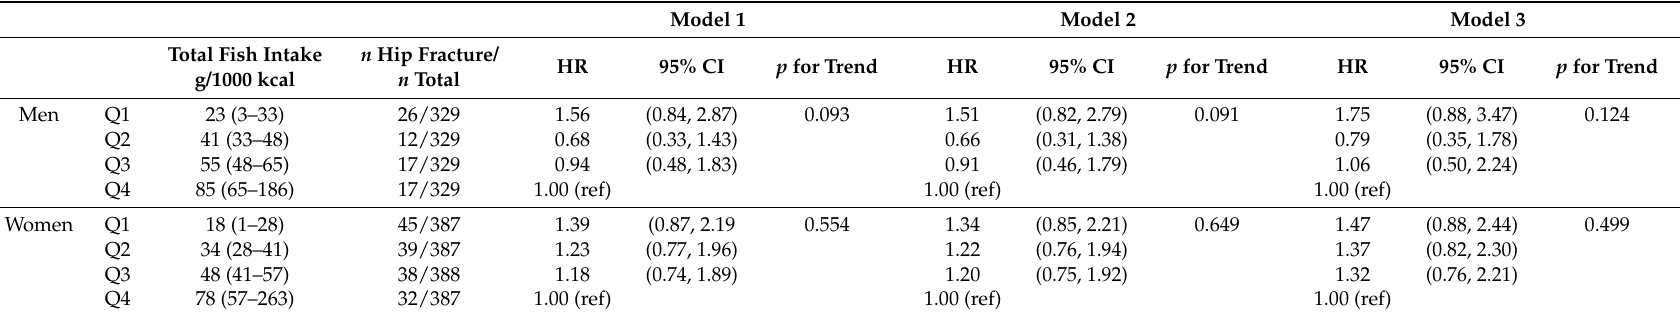
Table 3. Cox proportional hazards regression analysis of risk of hip fracture according to sex-specific quartiles (Q1–Q4) of baseline total fish intake among men ( n = 1315) and women ( n = 1548) in the Hordaland Health Study followed from inclusion in 1997–1999 (age 71–74 years) until 31 December 2009.